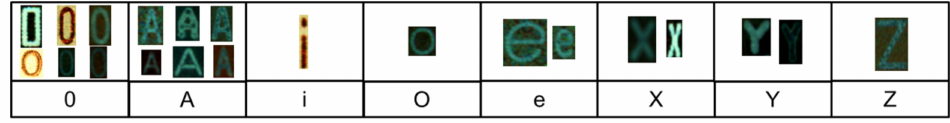
Figure 5. Examples of image types in each